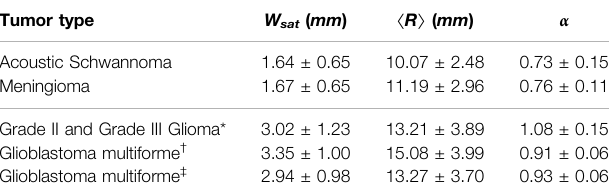
TABLE 2 | Scaling analysis results for global dynamics of the tumor interface